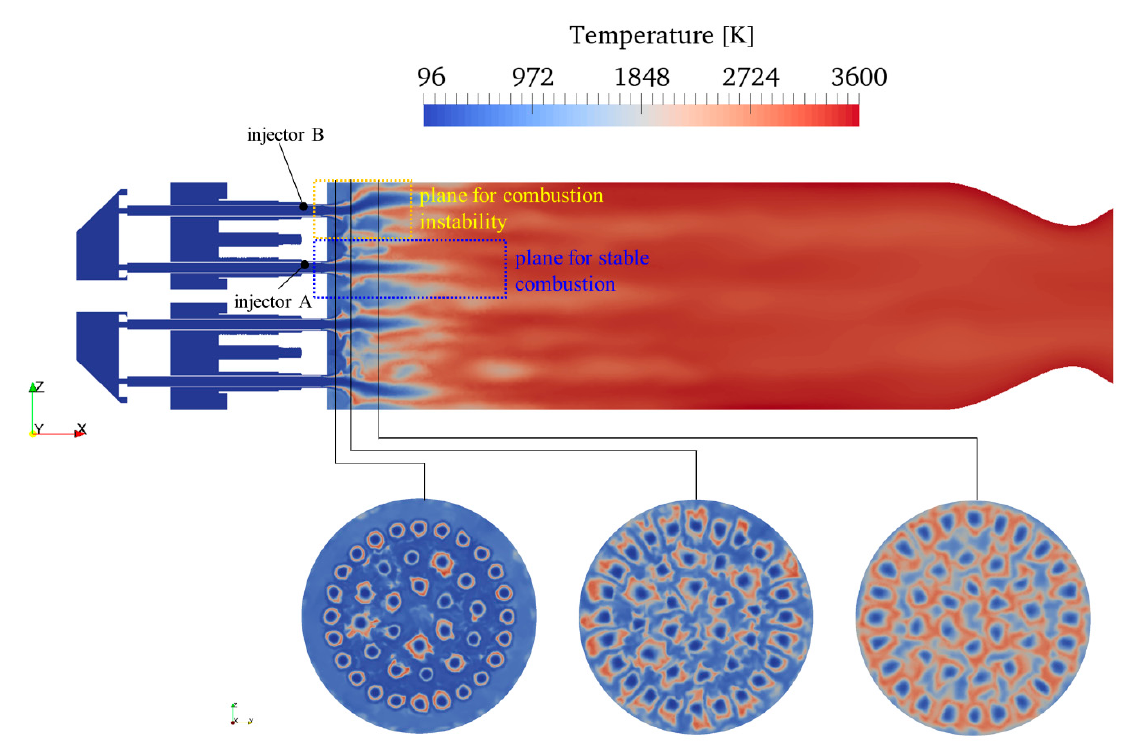
Figure 6. Longitudinal and transverse slice plots of the instantaneous temperature field with the analysis planes of injectors A and B for the stable combustion and combustion instability analysis, respectively.